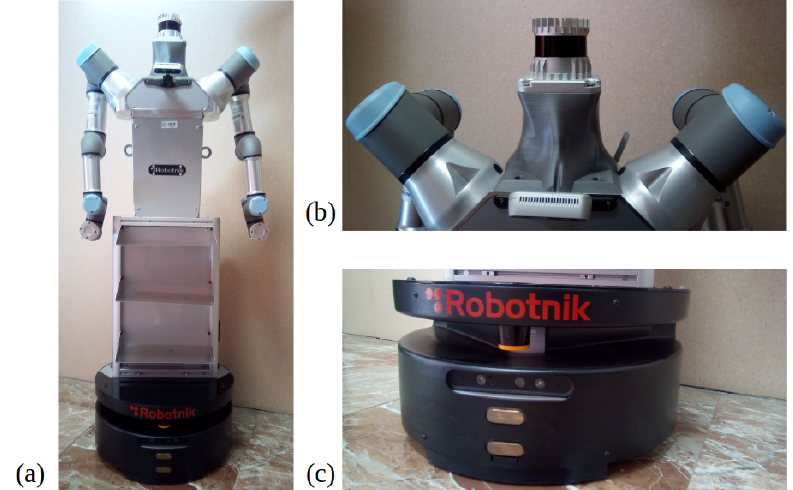
Figure 6. Robotic platform used for the experiments: ( a ) general robot appearance,( b ) close-up view of the Ouster LiDAR mounted on a 3D printed neck, ( c ) close-up view of the robot base, where the Hokuyo laser is mounted (orange